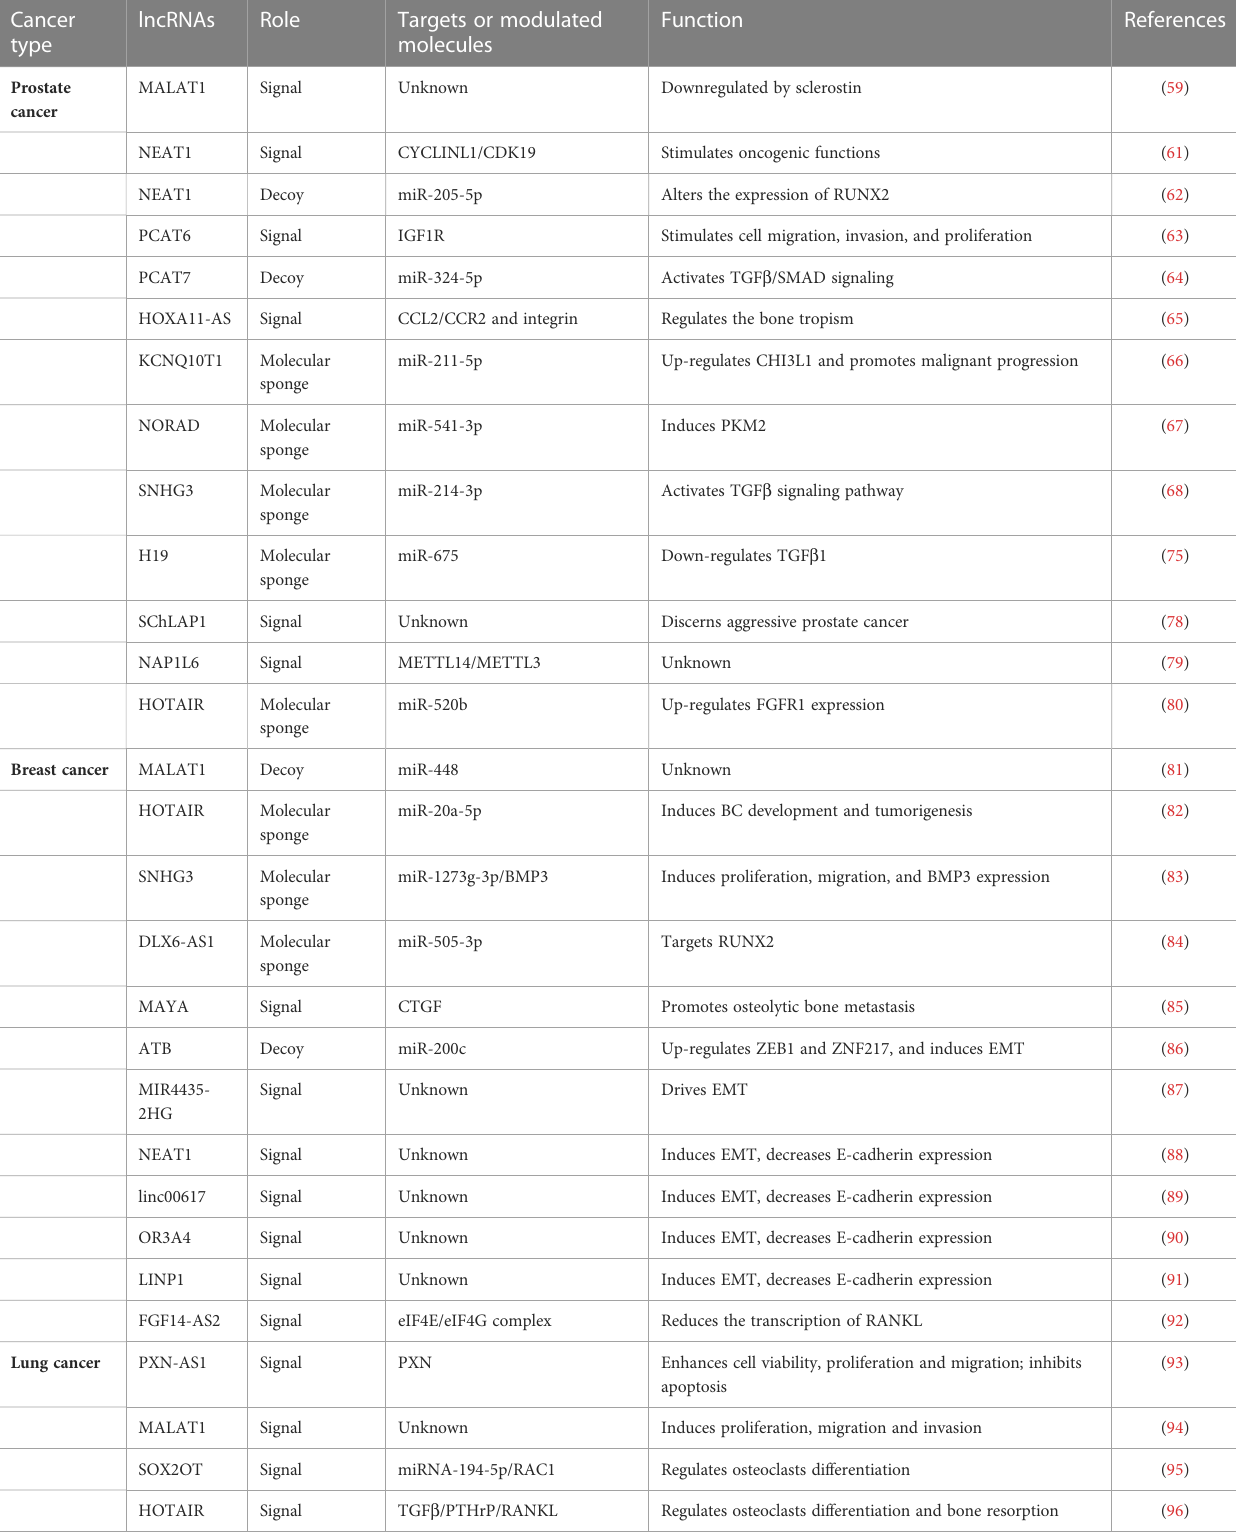
TABLE 1 Lists of the lncRNAs involved in the bone metastatic process in prostate, breast, and lung